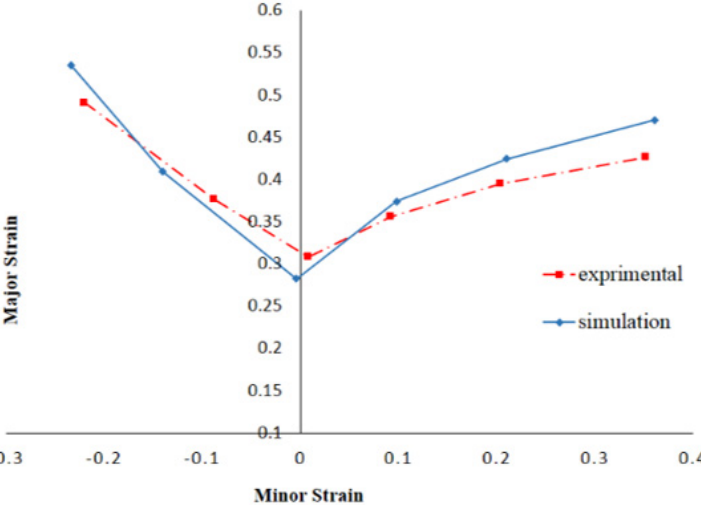
Figure 8. Comparing the experimental and simulated FLDs for a 1 mm-thick AA 6061 sheet at 20 mm/min speed.